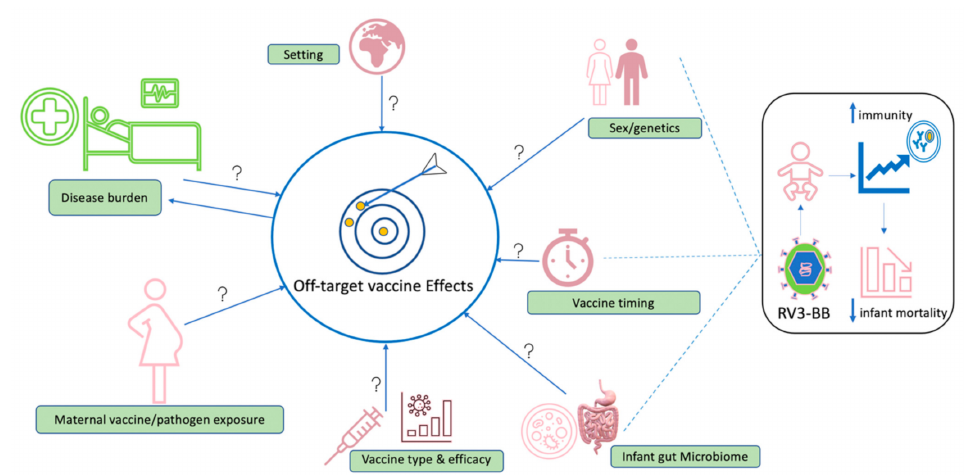
Figure 3. Potential areas that require further study in the context of off-target effects of vaccina- tion. Factors with potential to influence induction of off-target effects include geographical setting, sex/genetics, vaccine type, performance and vaccine co-administration, vaccine timing, composition of gut microbiome, prior maternal exposure to vaccine or microbes and disease burden in endemic settings. We hypothesise that a live-attenuated rotavirus vaccine (RV3-BB) may cause the develop- ment of beneficial off-target vaccine effects when administered at birth, with the potential to interact with sex and infant gut microbiome contributing to overall reduced infant